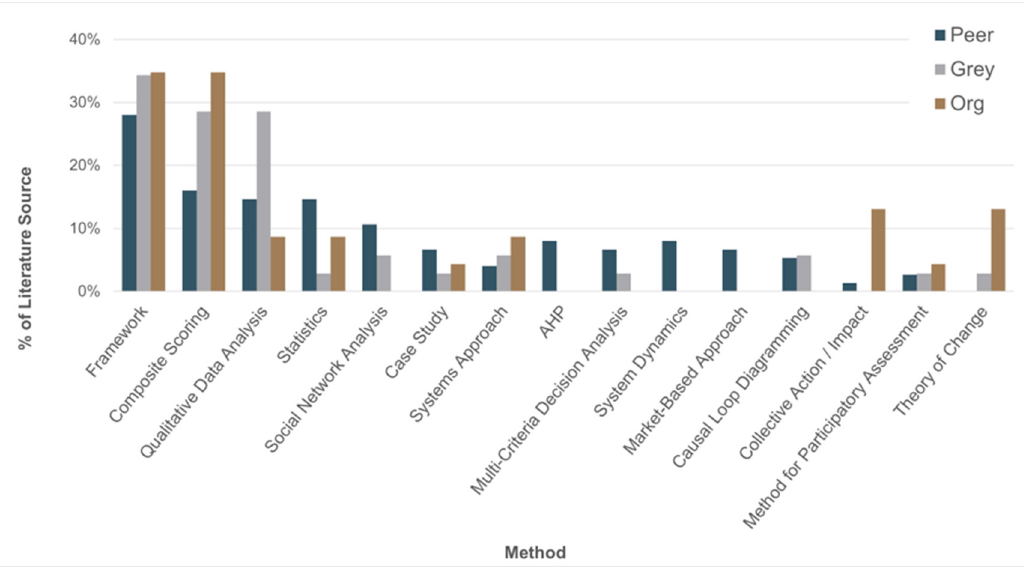
Figure 2. Relative frequency of the 15 most frequently used methods by literature source, listed in descending order of frequency of total references from all literature sources (peer-reviewed = 75; grey = 35, organizational (org) = 23).